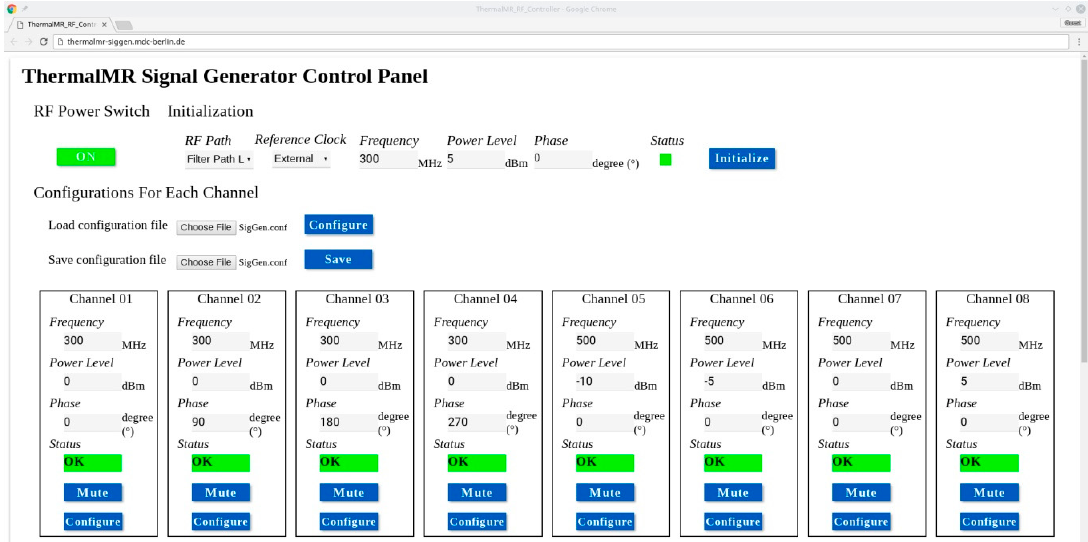
Figure 7. The web-based graphic user interface used for controlling the 32-channel signal generator. For simplicity only eight out of 32 channels are shown. The RF Power Switch controls the power supply to the analog circuits in the signal generator. The status indicator shows green when the corresponding channel runs normally. If errors happen, the indicator turns into red. Each channel can be muted independently by pressing the Mute button.